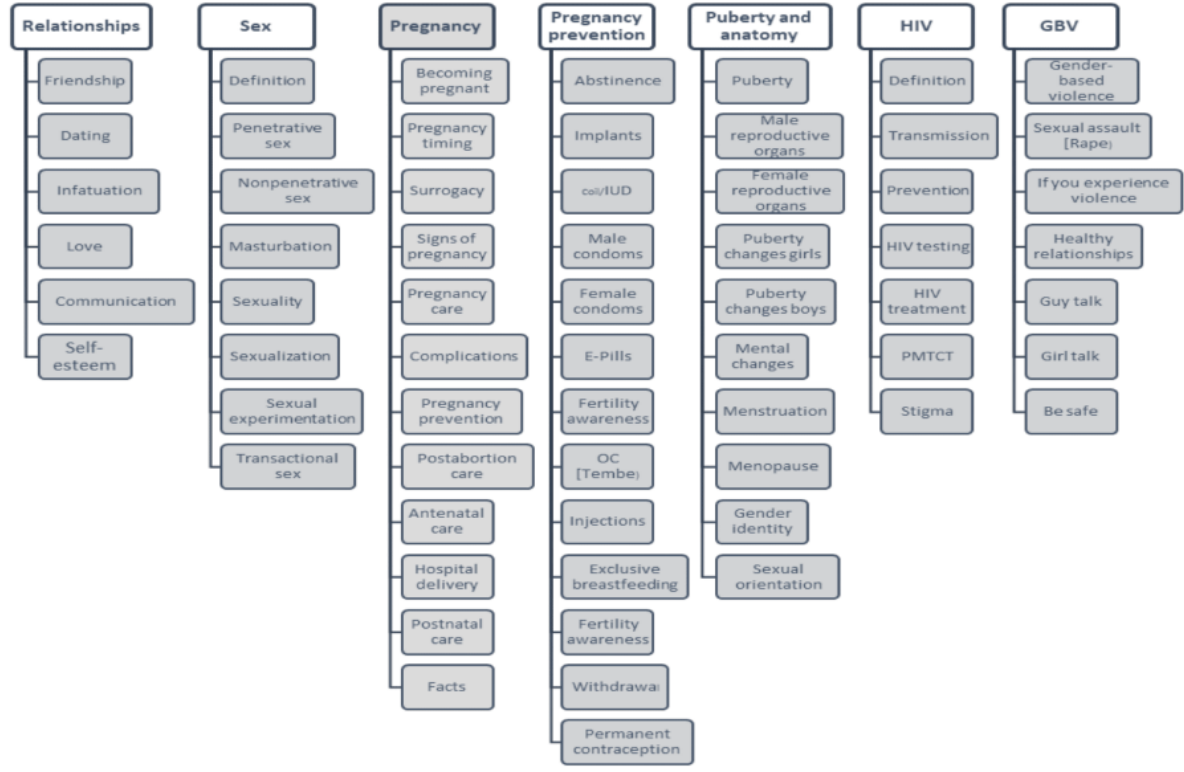
Figure 2. Adolescent/Youth Reproductive Mobile Access and Delivery Initiatives for Love and Life Outcome intervention arm architecture showing domains and subdomains. ARMADILLO: Adolescent/Youth Reproductive Mobile Access and Delivery Initiatives for Love and Life Outcome. Pregnancy Prevention. GBV: gender-based violence; IUD: intrauterine device; E-pills: emergency contraceptive pills; OC: oral contraceptives; PMTCT: prevention of mother to child transmission of HIV.